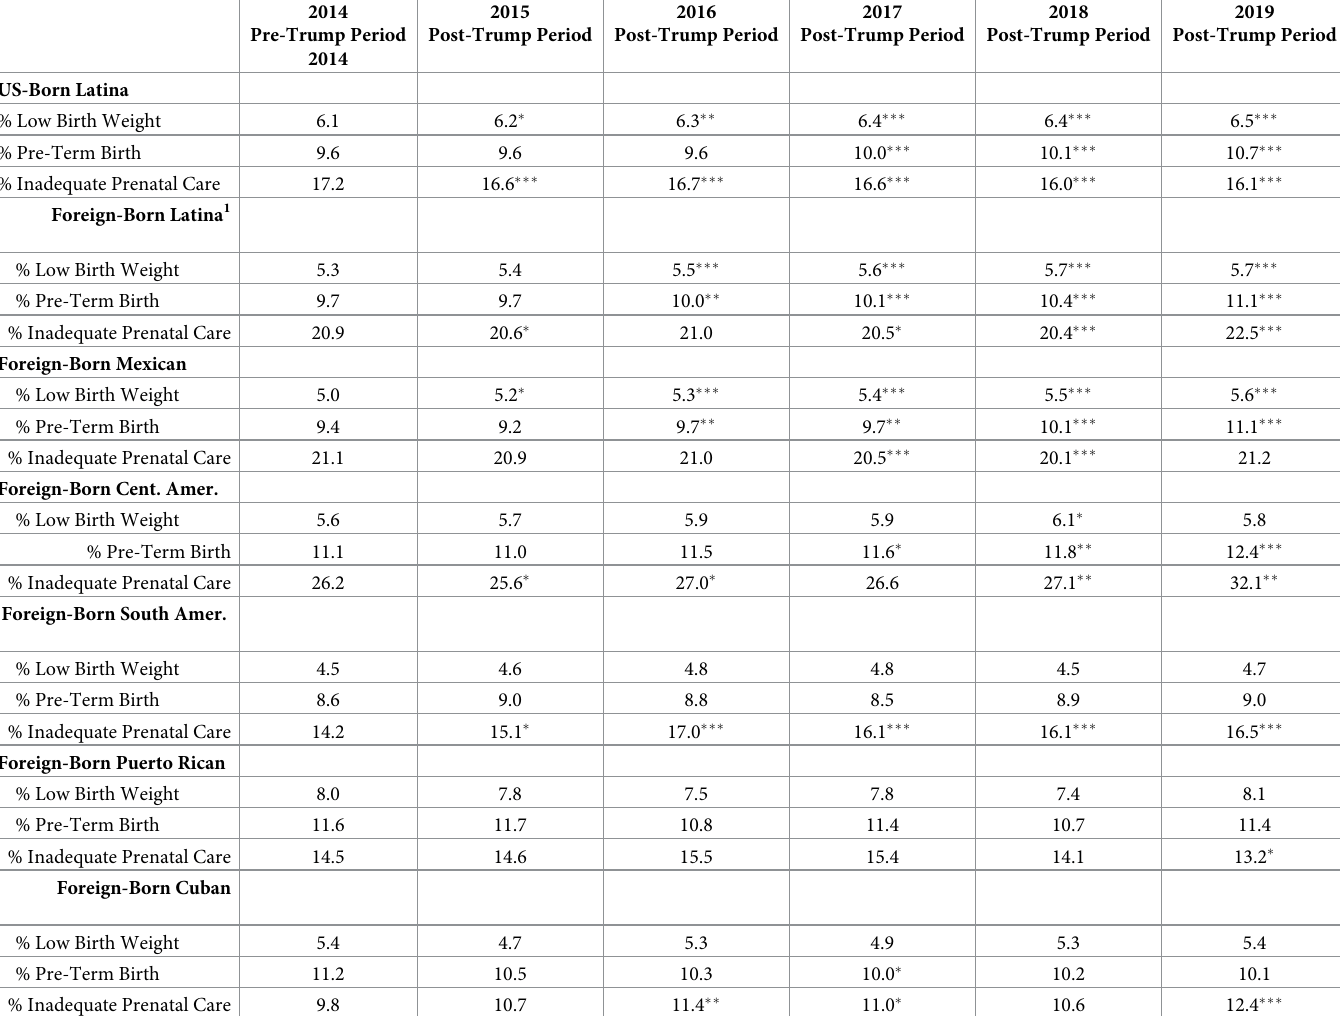
Table 3. Percentages of low birth weight, preterm birth, and inadequate prenatal care among US resident mothers across study periods (July 1 to Dec 31 in years